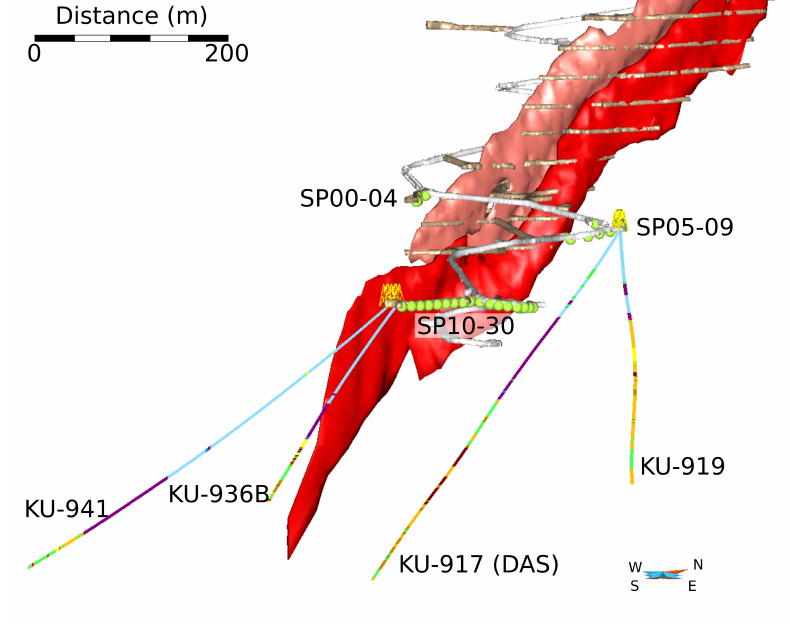
Figure 3. Geological model of the known Kylylahti sulfide deposit (red/pink). Boreholes used for VSP measurements (KU-917, KU-919, KU-936B, KU-941) are color-coded according to logged geology (see Figure 1). Seismic sources are indicated by green spheres in the mine